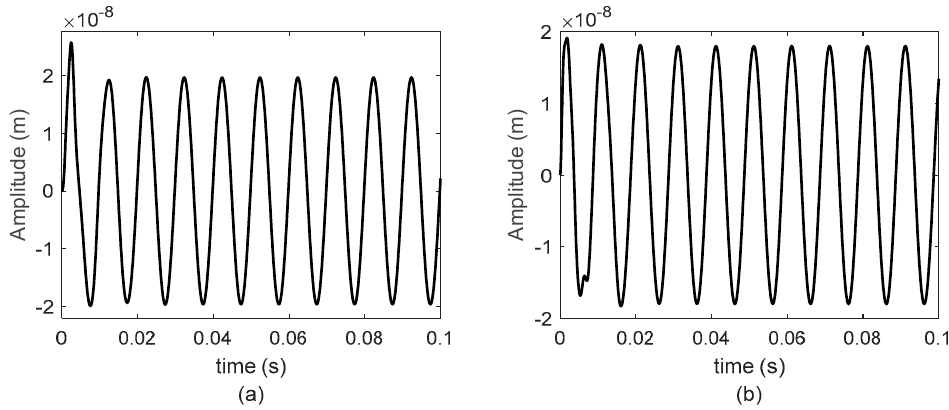
Figure 4. Vibration signal at node 4 (bearing 1) at 600 rpm: ( a ) X direction; ( b ) Z direction.